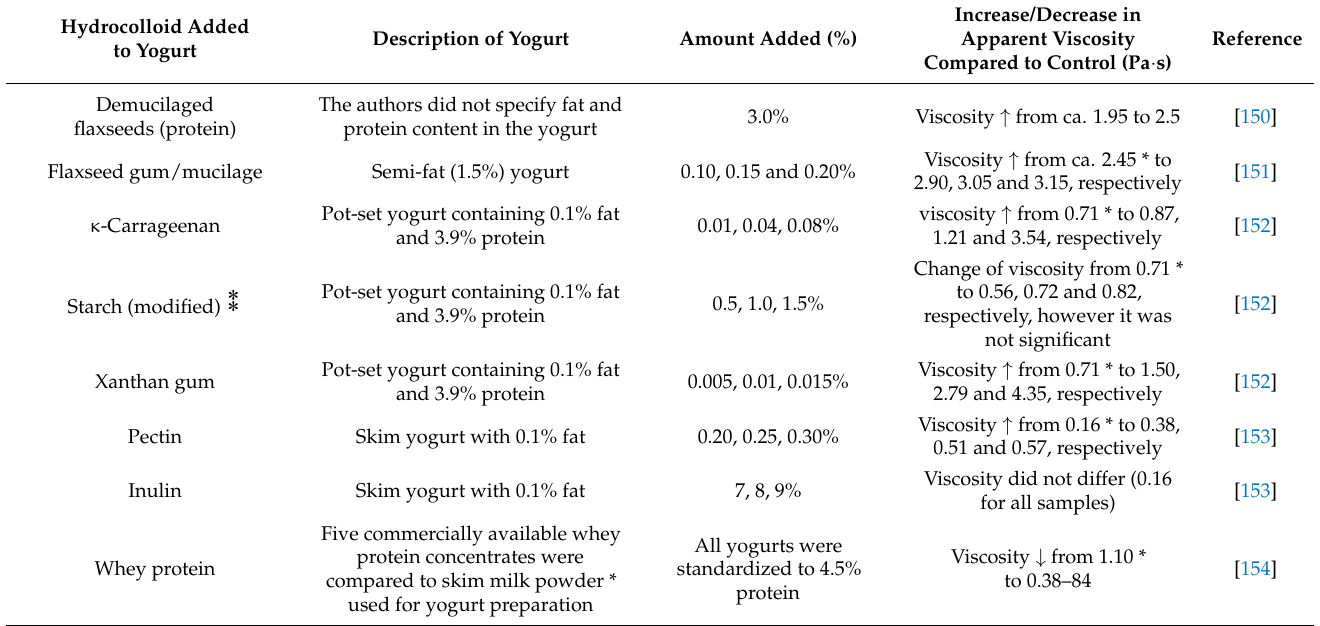
Table 6. Comparison of flaxseed gum and protein with other hydrocolloids as affecting apparent viscosity of yogurt.